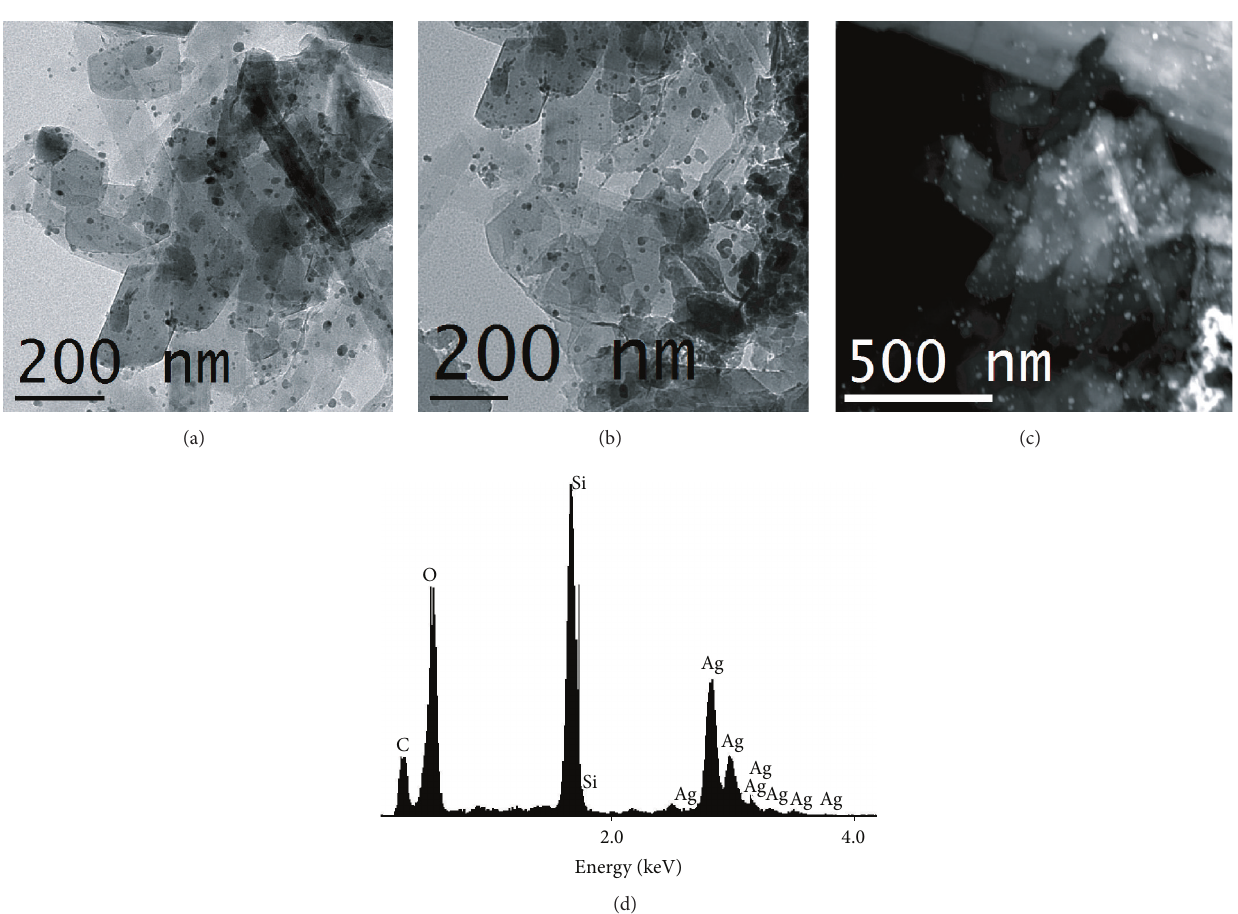
Figure 5: ((a) and (b)) Bright field TEM and (c) STEM images corresponding to the AgNPs distribution onto the zeolite surface. (d) EDS analysis of the zeolite-AgNPs